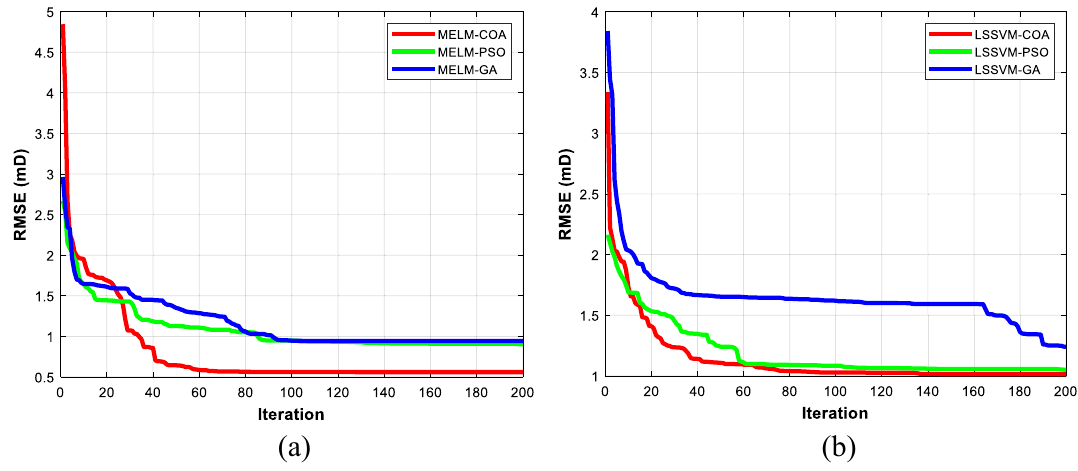
Fig. 9 Cross plots of RMSE versus iteration number for the hybrid (a) MELM and (b) LSSVM algorithms for modeling the permeability using the training